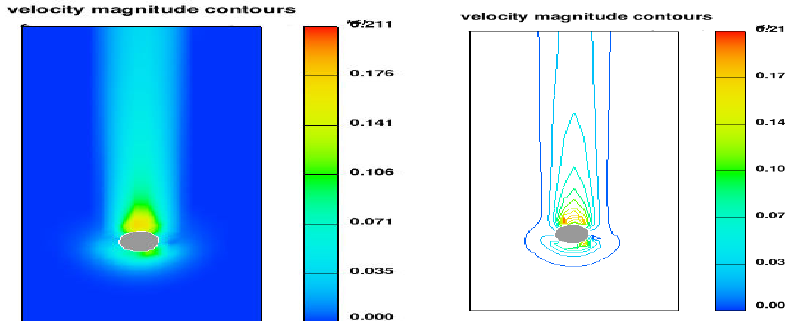
Fig. 3. Velocity magnitude contour of particle with diameter of 2.18 mm